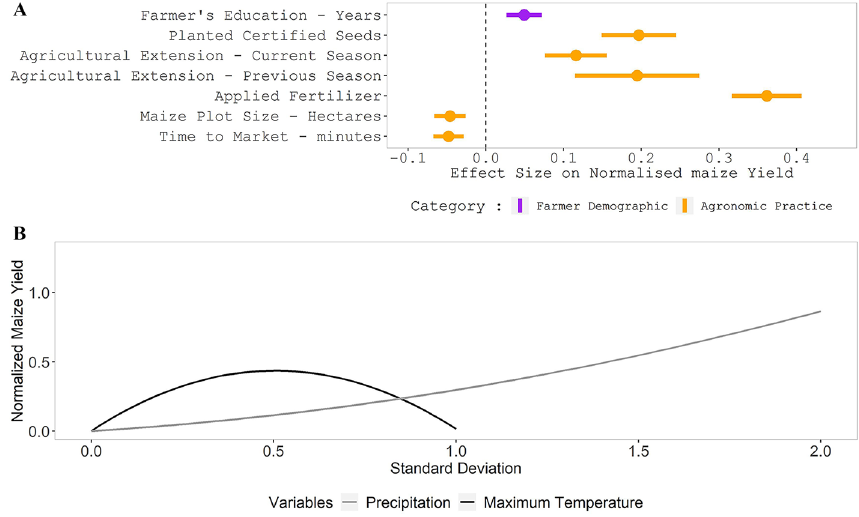
Figure 1. Effect sizes of variables with a significant relationship with normalized maize yield. The bars of similar color across each point ( A ) show the standard error. The effect sizes of climatic variables ( B ) with a significant relationship with normalized maize yield is non-linear because of the squared